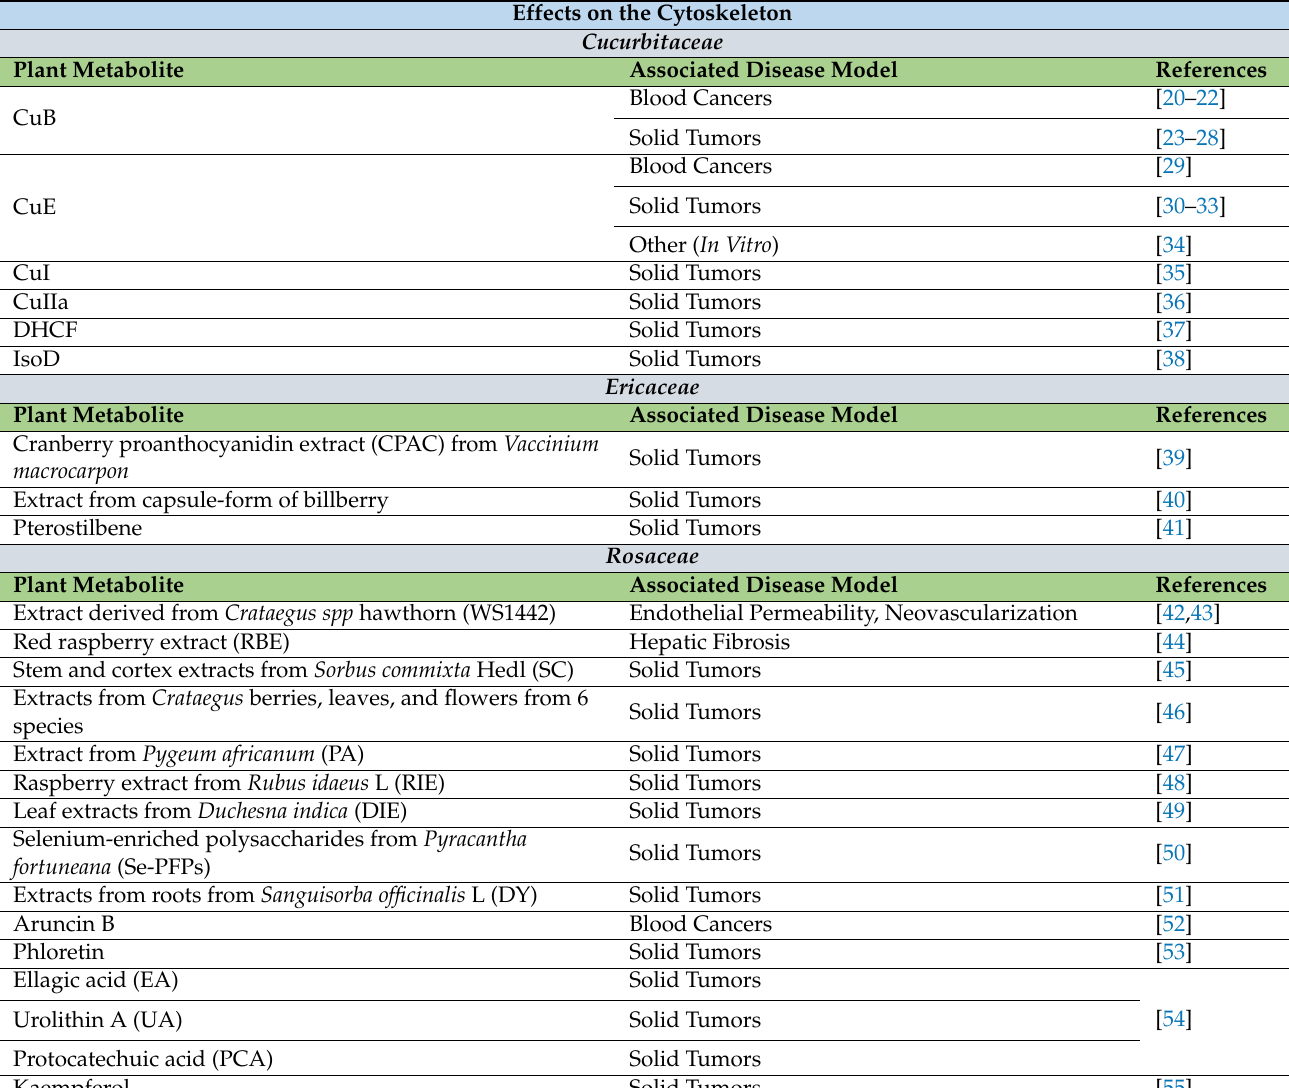
Table 4. Summary of Effects on the Cytoskeleton across the three plant